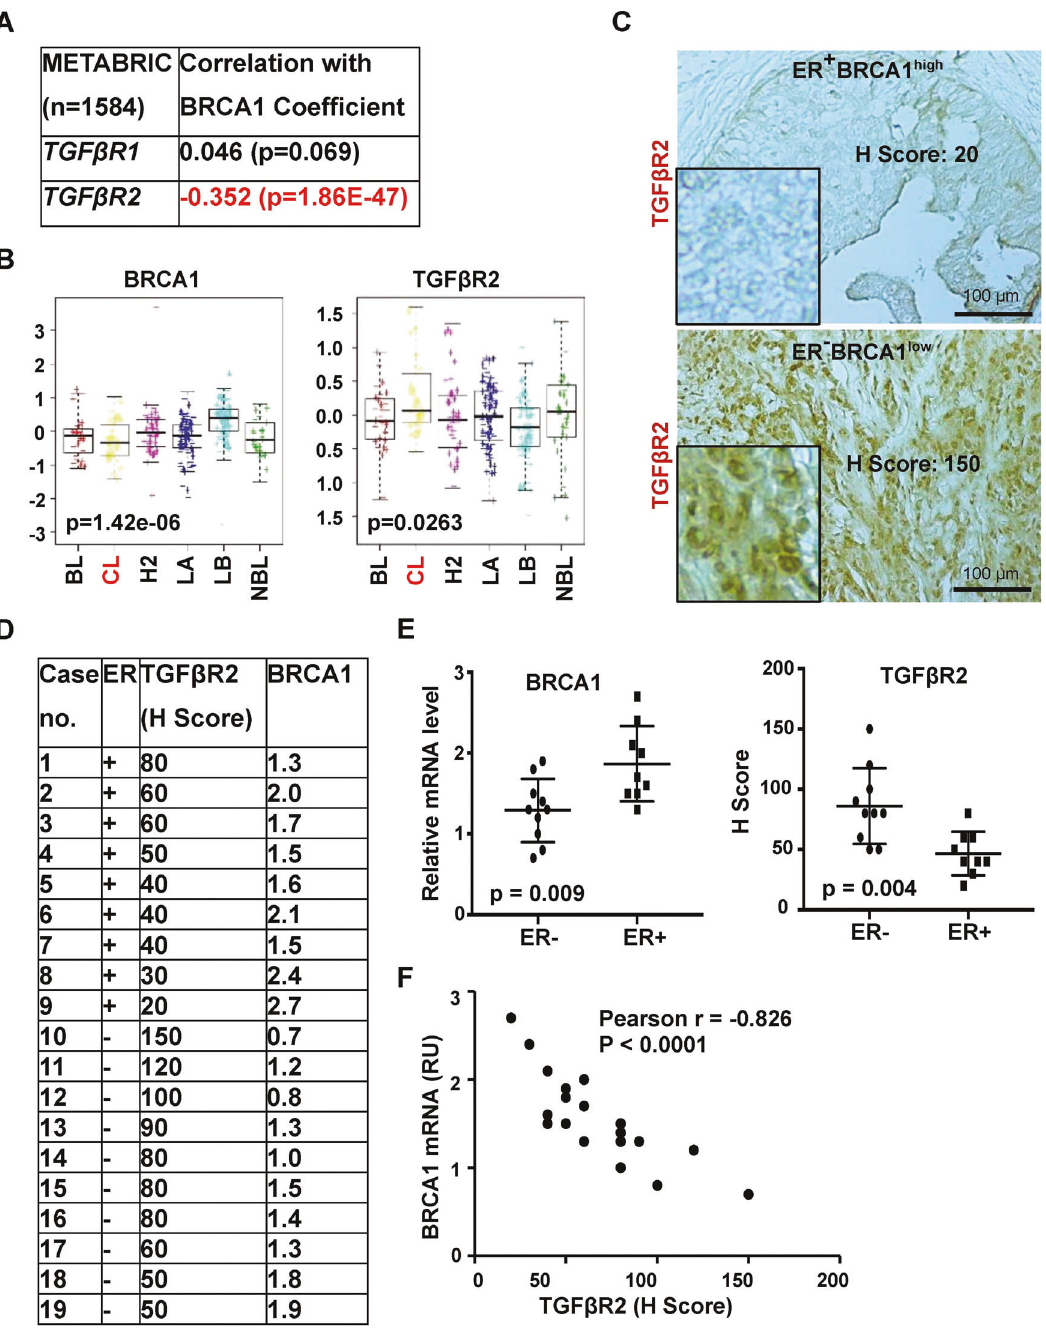
Fig. 7 BRCA1 and TGF β R2 levels are inversely related to the CL subtype of human breast cancer. A Correlation analysis of the expression of BRCA1 and TGF β R2 for MetaBric breast cancer patients. B Analysis of gene expression in NKI295 breast cancer patients according to tumor subtype. BL basal-like, CL claudin-low, H2 Her2-enriched, LA luminal A, LB luminal B, NBL normal breast-like. C Representative immunostaining of ER positive and negative invasive human breast cancers with antibodies against TGF β R2. D, E Summary of expression of TGF β R2 by IHC and BRCA1 by Q-RT-PCR ( D ). The expression levels of TGF β R2 were quanti fi ed by H-scores. The expression of BRCA1 was determined by Q-RT-PCR. BRCA1 mRNA levels relative to that of T47D cells were determined as we previously reported [19]. Analysis of the expression of TGF β R2 by IHC and BRCA1 by Q-RT-PCR in ER + and ER-invasive breast cancers ( E ). Statistical signi fi cance was determined by a two-tailed, unpaired T test. F Correlation analysis of BRCA1 mRNA levels and H scores of TGF β R2 expression for breast cancer also builds upon the body of work showing a correlation between EMT and the CL subtype [4, 35, 36] by showing a mechanistic de fi cient tumor cells reduced EMT and suppressed tumorigenesis connection between BRCA1 and TGF β signaling in an epithelium- and metastasis. Moreover, we found BRCA1 mRNA was low and autonomous manner. TGF β R2 mRNA was high in the claudin-low TNBC subtype. Thus, While our study demonstrates TGF β R2 induces malignant BRCA1 function may not only be implicated in the basal-like phenotypes in p18/BRCA1-de fi cient tumors, other studies show molecular subtype but also in claudin-low as well. Importantly, this